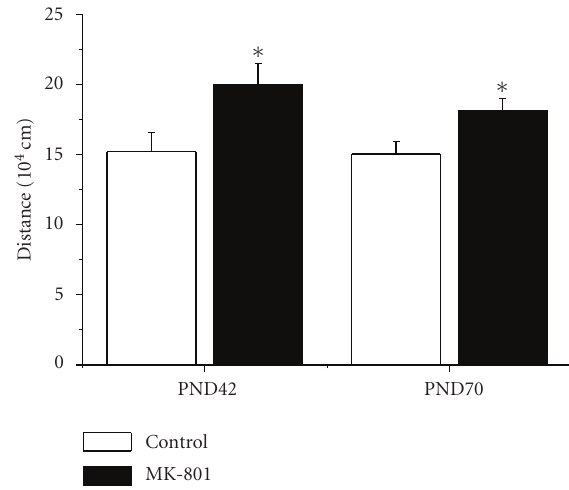
Figure 1: Neonatal MK-801 treatment increased the total locomo- tor activity on both PND 42 and PND 77. ∗ , P < .